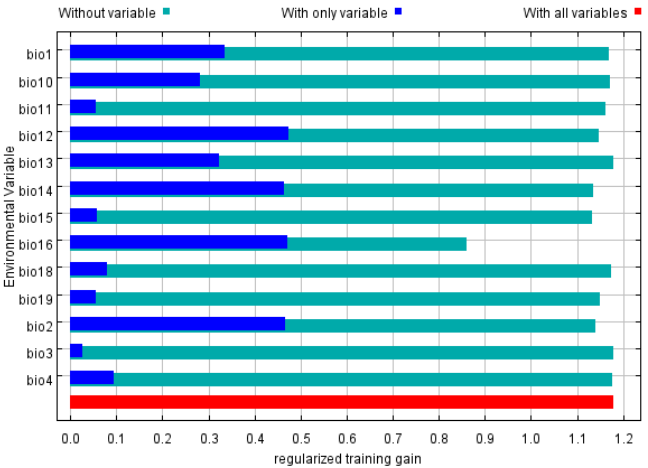
Table 3. Contributions of the environmental variables to the MaxEnt model.